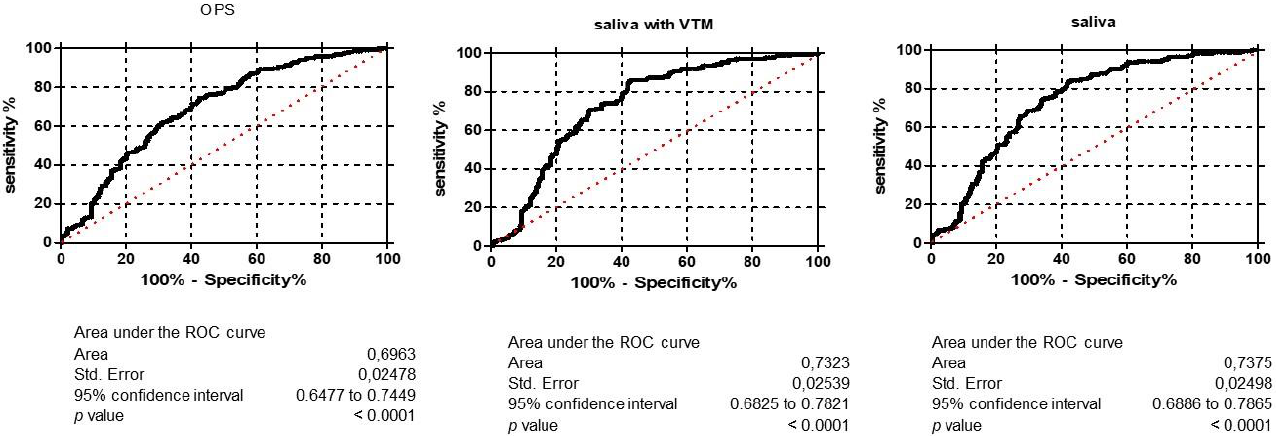
Figure 2. Area under the ROC curve (AUC) of OPS, saliva and saliva with VTM. NPS: nasopharyngeal swab, OPS: oropharyngeal swab, saliva—VTM: saliva with viral transport medium. Ct: cycle threshold.